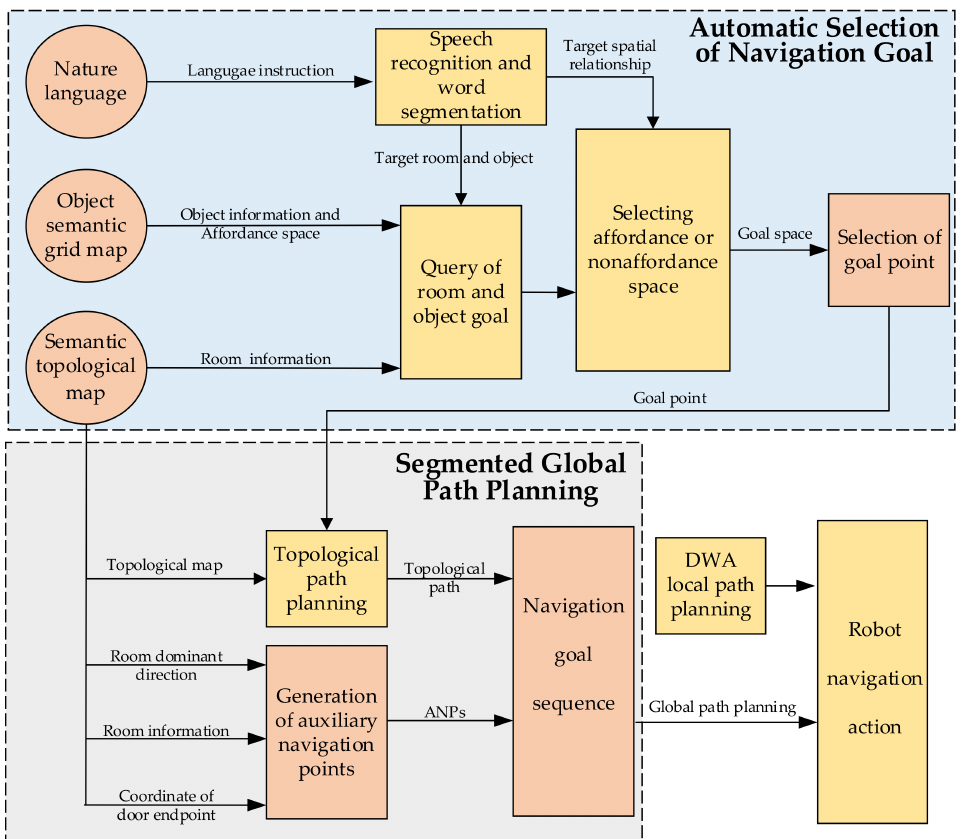
Figure 1. System overview. The system contains two major parts: automatic selection of navigation goal and segmented global path